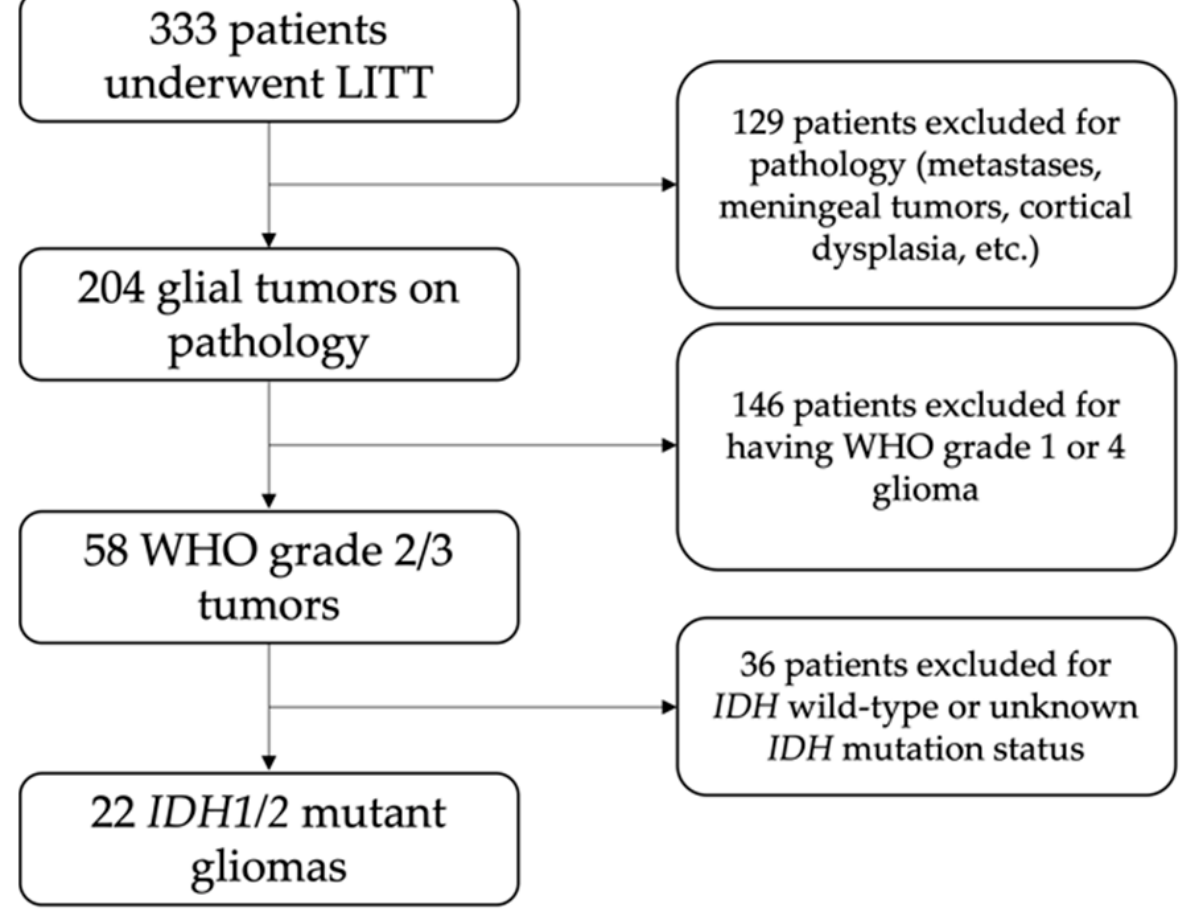
Figure 1. Flowchart of patient selection.